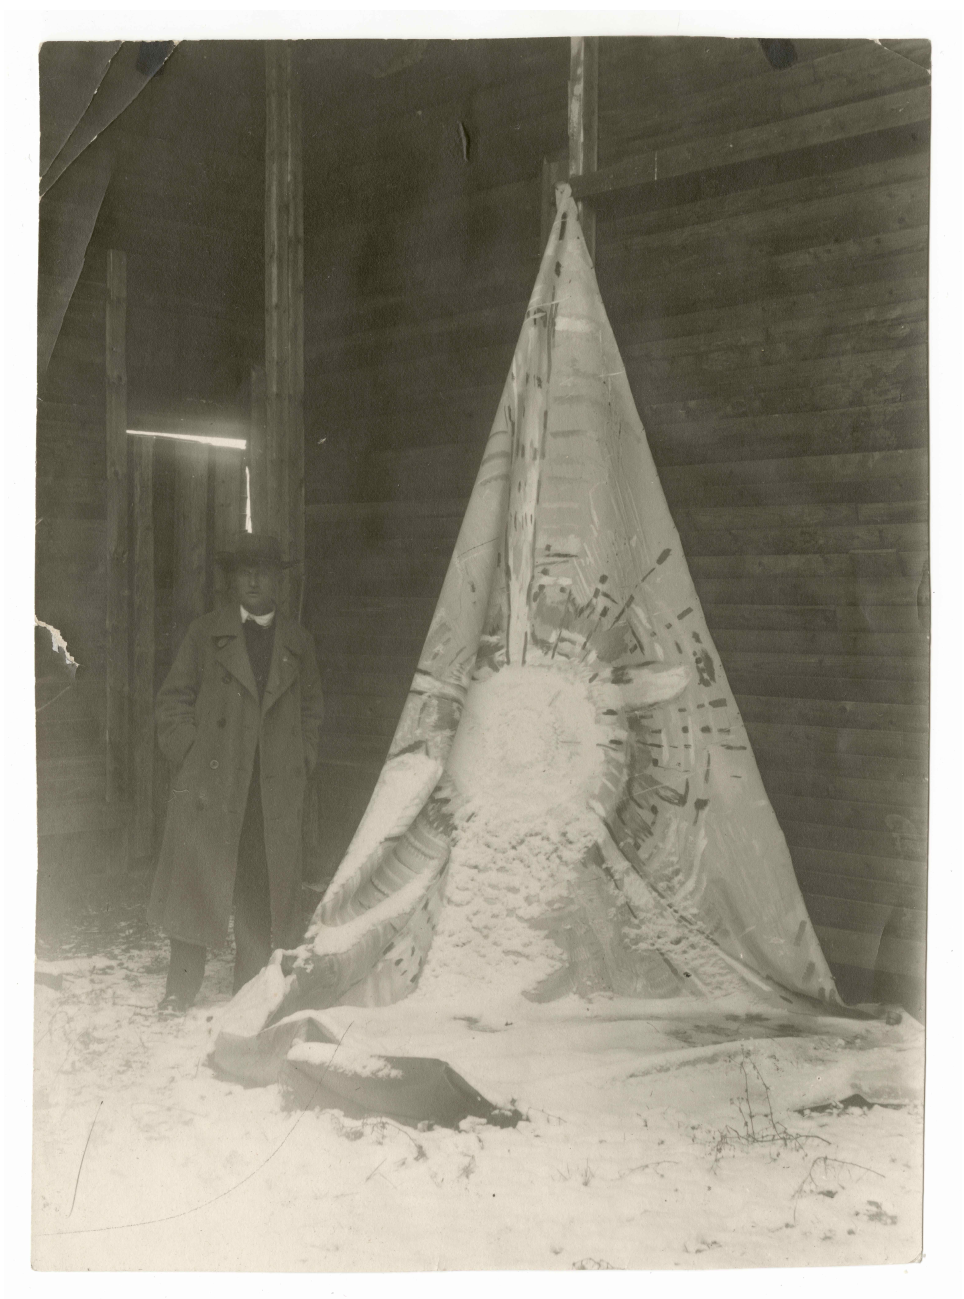
Figure 4: Munch stands beside The Sun, which is partly covered by snow. MM.B.02394 ©